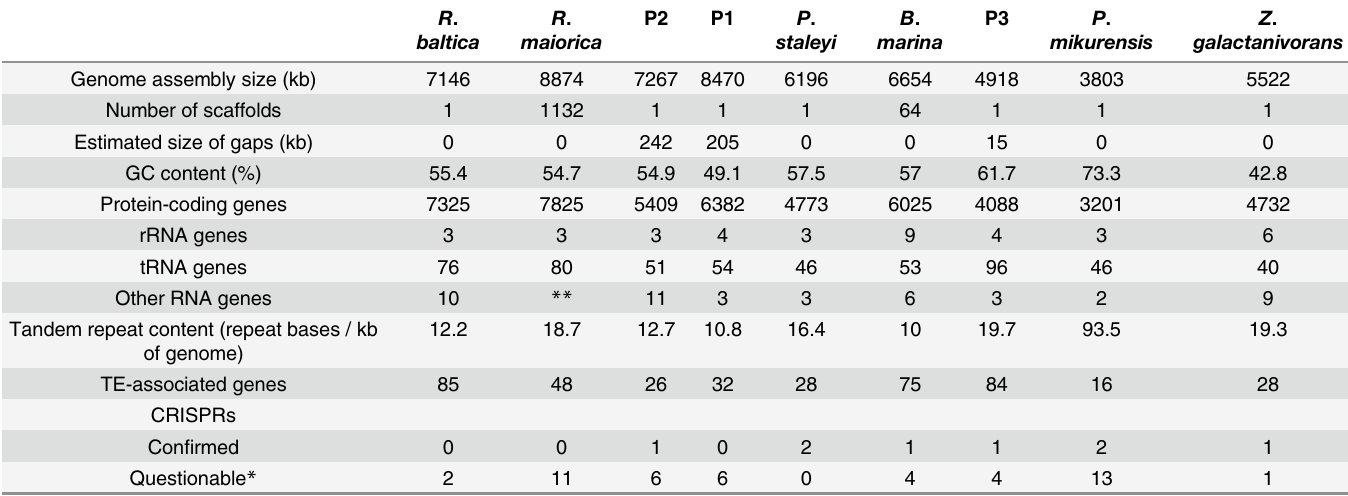
Table 1. Properties of 9 bacterial genome assemblies including 8 Planctomycetes and 1 marine Bacteroidetes. P1, P2 and P3 were sequenced from a blade of Porphyra umbilicalis . Strains of R . baltica , P . mikurensis and Z . galactanivorans (Bacteroidetes) were also present on the blade (based on 16S rDNA analysis). P . staleyi , R . maiorica and B . marina are the closest known relatives of P1, P2 and P3, respectively.